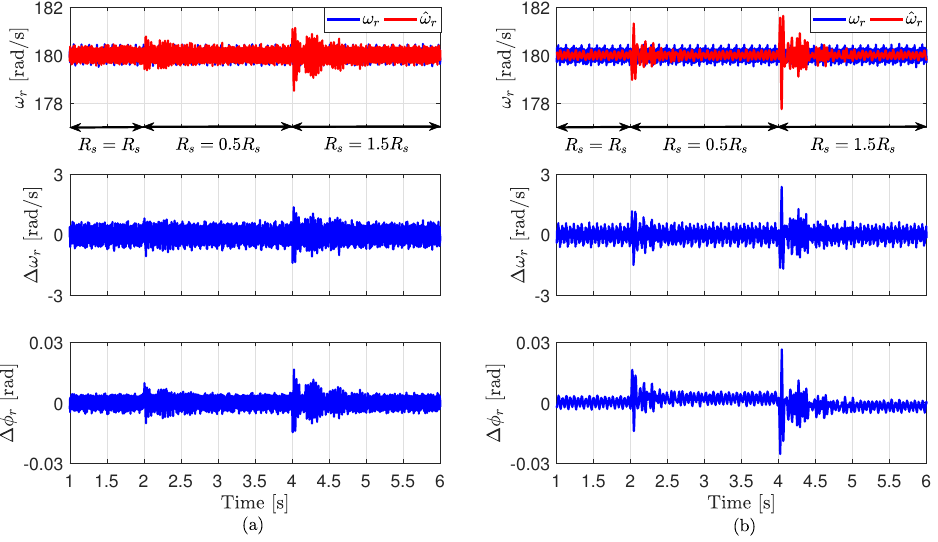
Figure 9. Experimental performance under step changes in the stator resistance R s of the SMPMSG: ( a ) MRAS-FS observer, and ( b ) classical